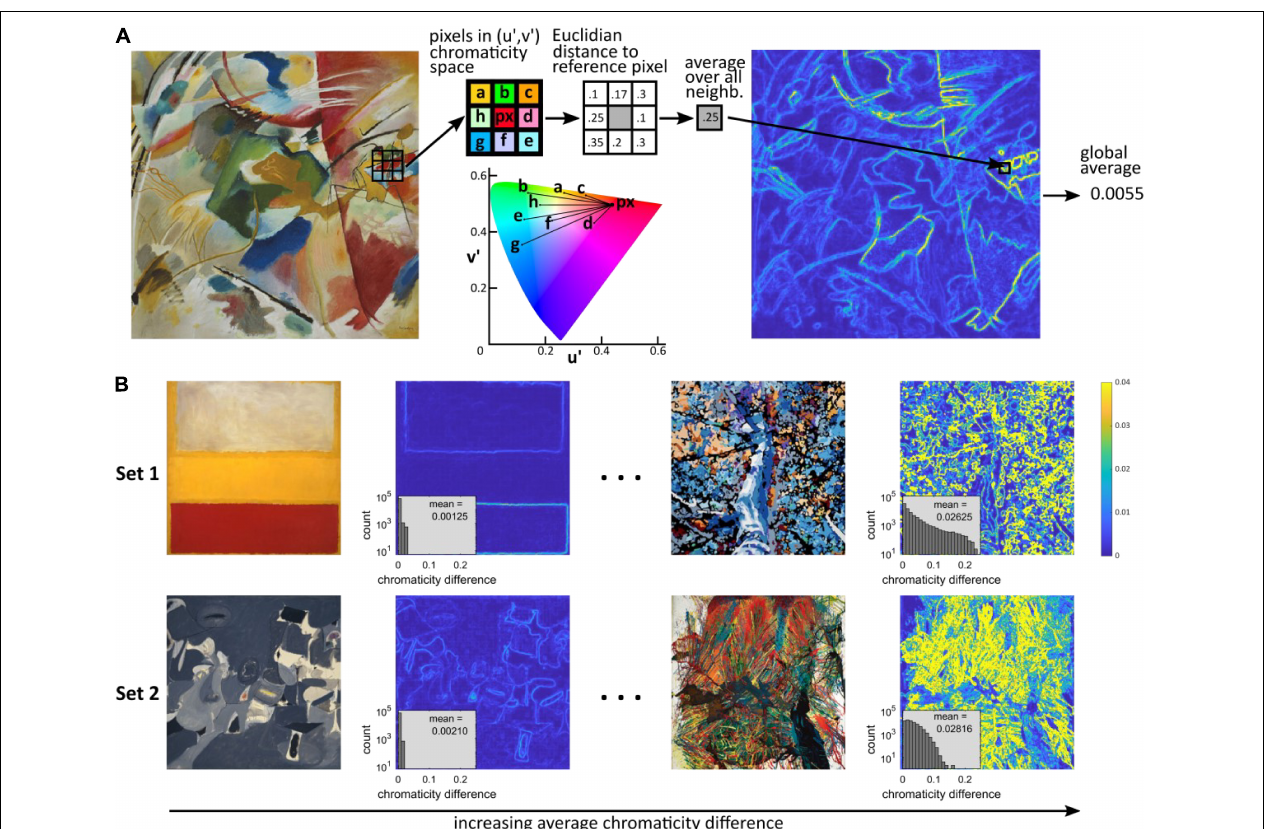
FIGURE 1 | Computation of chromaticity difference. (A) Computation of the average chromaticity difference of an image. We computed the u (cid:48) and v (cid:48) coordinates in the CIELUV chromaticity space for each pixel (px) and its 8-connected neighboring pixels (a to h). We then computed the Euclidian distance between the chromaticity of the reference pixel and the chromaticity of each of the 8 neighboring pixels in the (u (cid:48) ,v (cid:48) ) plane (i.e., independently of any difference in luminance). These distances were then averaged to give the chromaticity difference for each reference pixel, which provided a “heatmap” of local chromatic difference. The color metric, average chromaticity difference, was computed as the average of the local chromaticity differences over the whole image. (B) Image with the lowest (left) and highest (right) average chromatic difference in Set 1 (top row) and Set 2 (bottom row), and corresponding heatmap of local chromaticity differences. The plots inserted in the heatmaps show the histograms of local chromatic differences and average value (count shown on a logarithmic scale). The images were cropped from the following works of art: Top left: Wassily Kandinsky, “Painting with green center”; Set 1 left: Mark Rothko, “No. 13”; Right: Randy Honerlah, “Letting Go”; Set 2 left: Arshile Gorky, “Soft Night”; right: Shozo Shimamoto, “Explosion 64-1.”